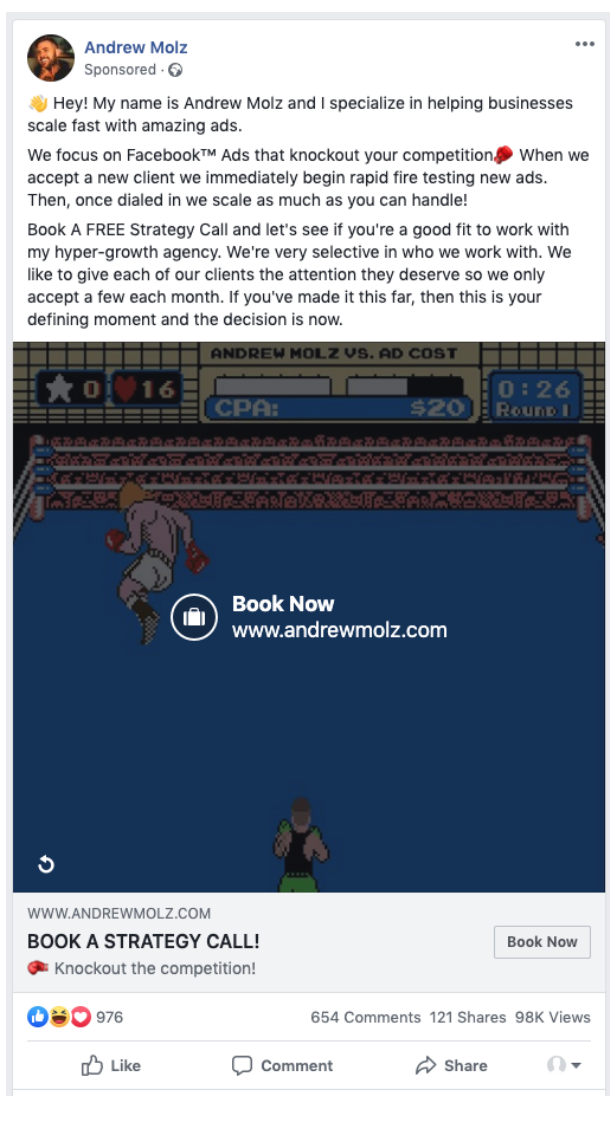
Figure 1. Example of a real malvertising ad delivered to a real FB